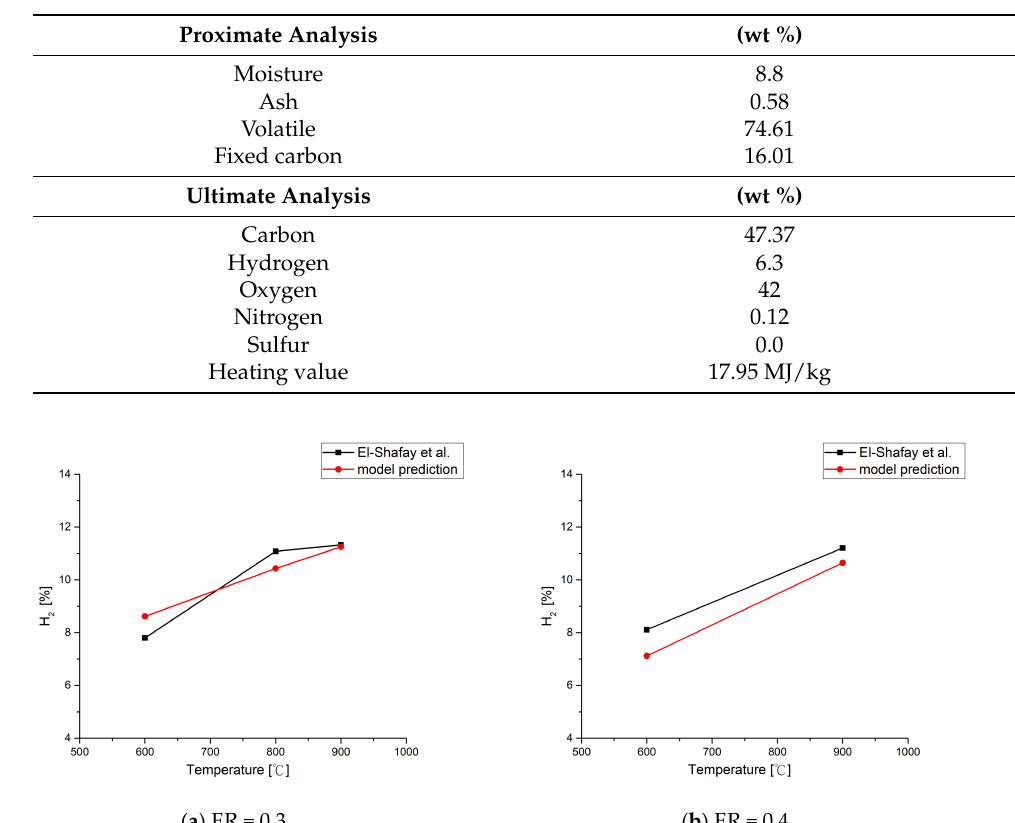
Table 4. Proximate and ultimate analyses of the sawdust pellets [58].